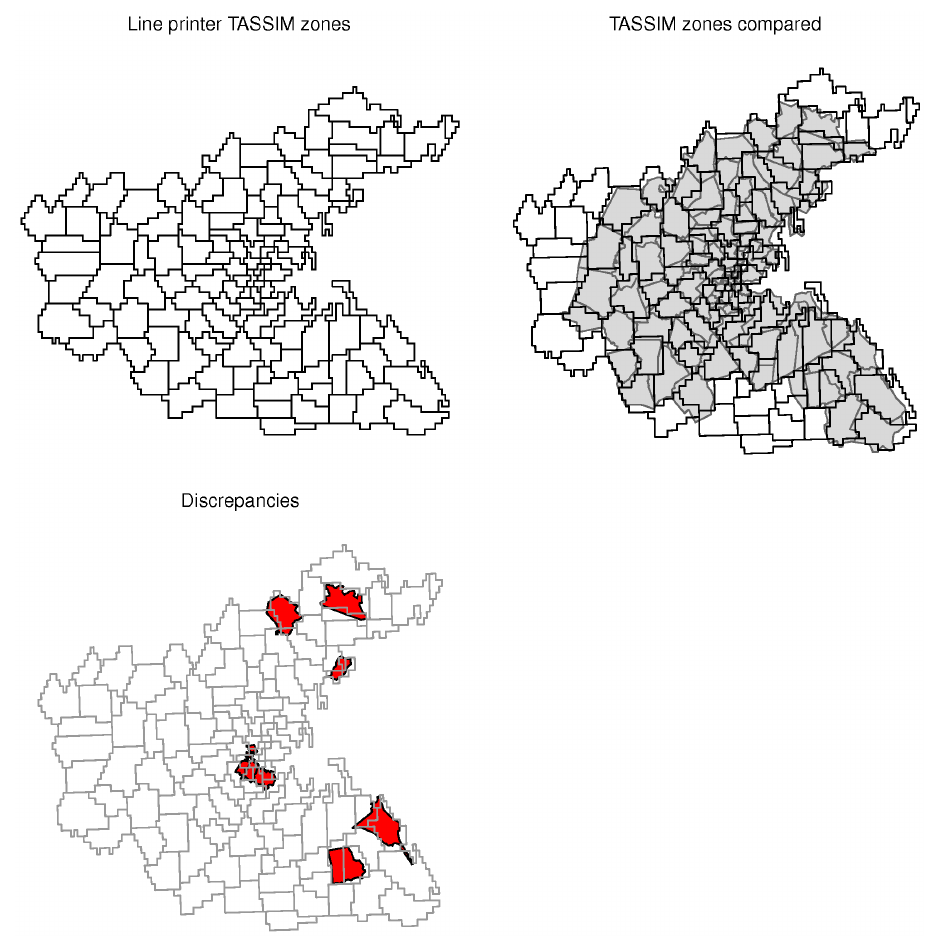
Figure A.3: TASSIM zone boundaries retrieved from line printer output compared with approximate TASSIM zones retrieved from 506 Census tract data set; upper left panel: boundaries of 122 line printer zones; upper right panel: affine-transformed line printer zones overlaid over 96 homogeneous and contiguous NOX zones from census tract dataset; lower left panel: discrepancies between the two boundary sets.